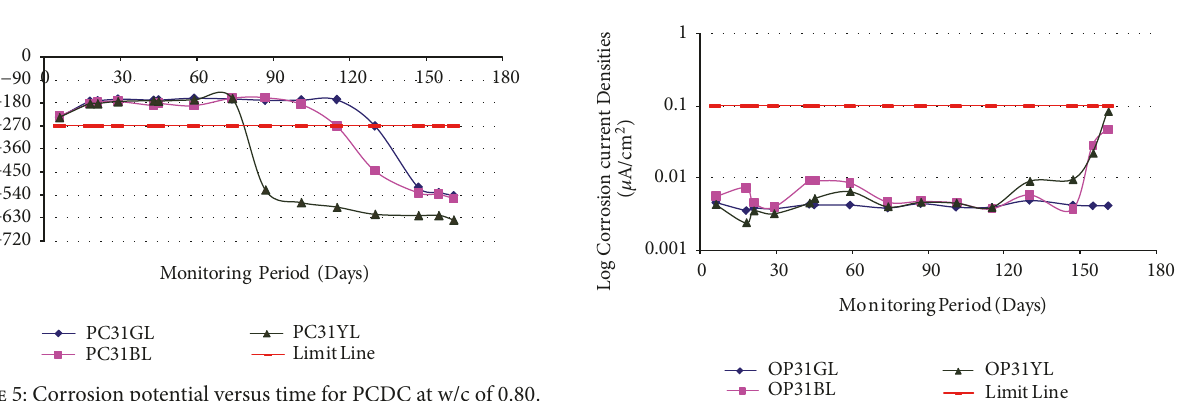
Figure 5: Corrosion potential versus time for PCDC at w/c of 0.80.